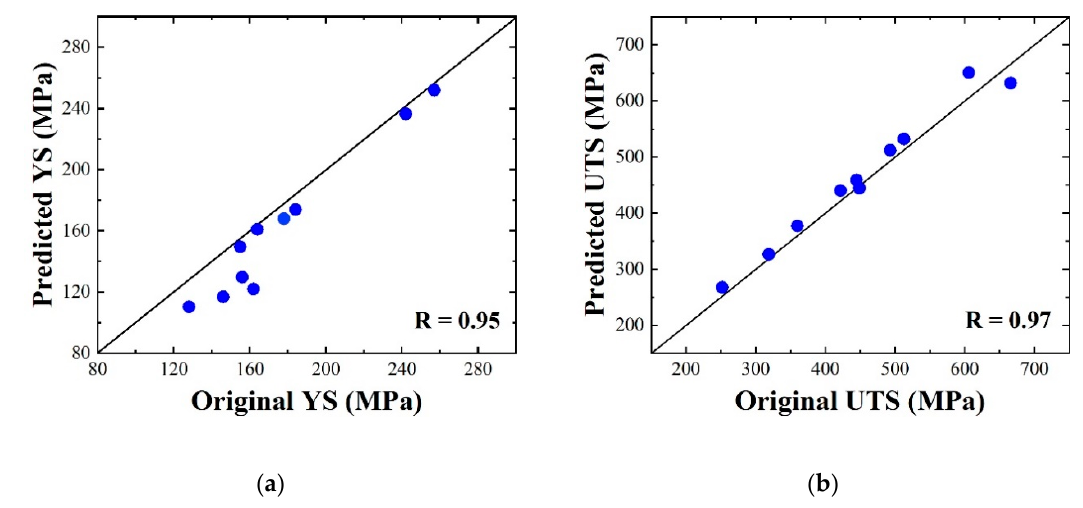
Figure 5. Comparison between the predicted and original values of the unseen data outside the database for: ( a ) YS and ( b ) UTS.